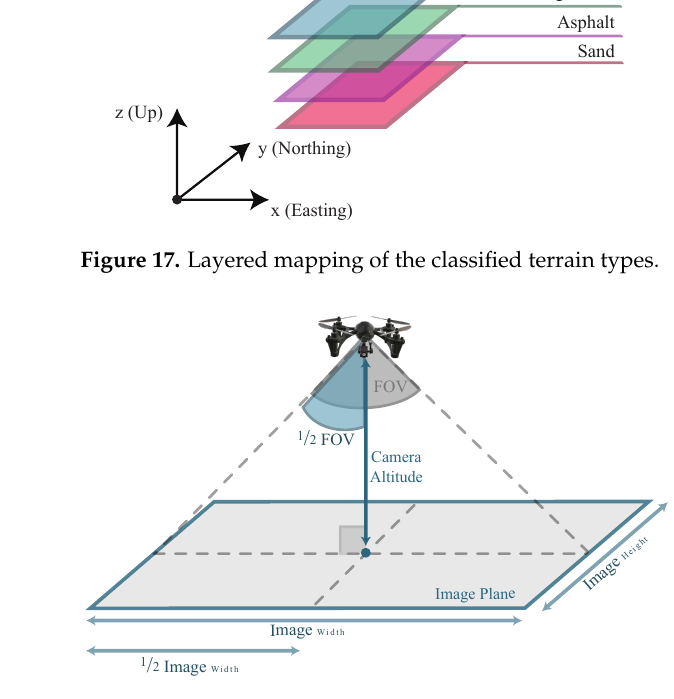
Figure 18. Schematic of how to determine the real image plane dimension.